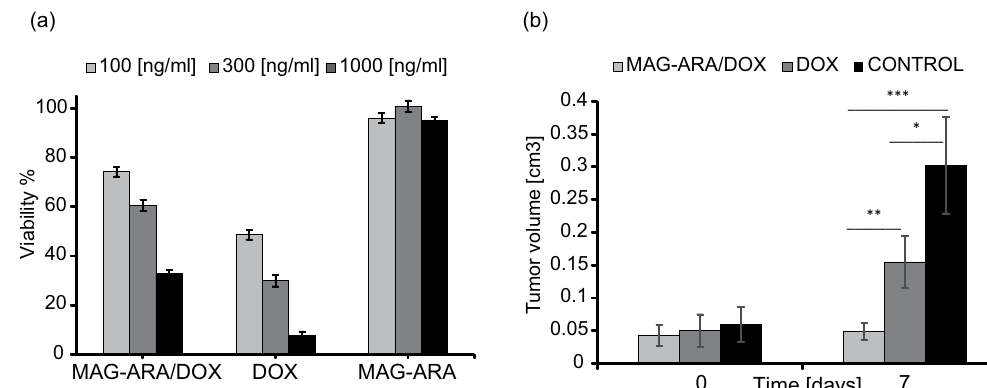
Figure 2. Biological properties of MAG-ARA/DOX NPs. ( a ) In vitro toxicity and efficacy of MAG-ARA/DOX NPs (MAG-ARA/DOX) in comparison to soluble DOX (DOX) and nonfunctionalized MAG-ARA NPs in three different concentrations. Experiments were performed in MDA-MB-231 cells and viability was assessed with MTT colorimetric assay. Viability is calculated as percentage of absorbance of untreated cells. ( b ) Bargraph indicating tumor volumes of MDA-MB-231 xenografts treated with MAG-ARA/DOX, soluble DOX (DOX) and vehicle (control), at the time therapy commences (Day 0) and 7 or 14 days later. MAG-ARA/DOX NPs used in these experiments were also coated with FA-PEG2000. * Designates P value < 0.05 and *** designates P value <